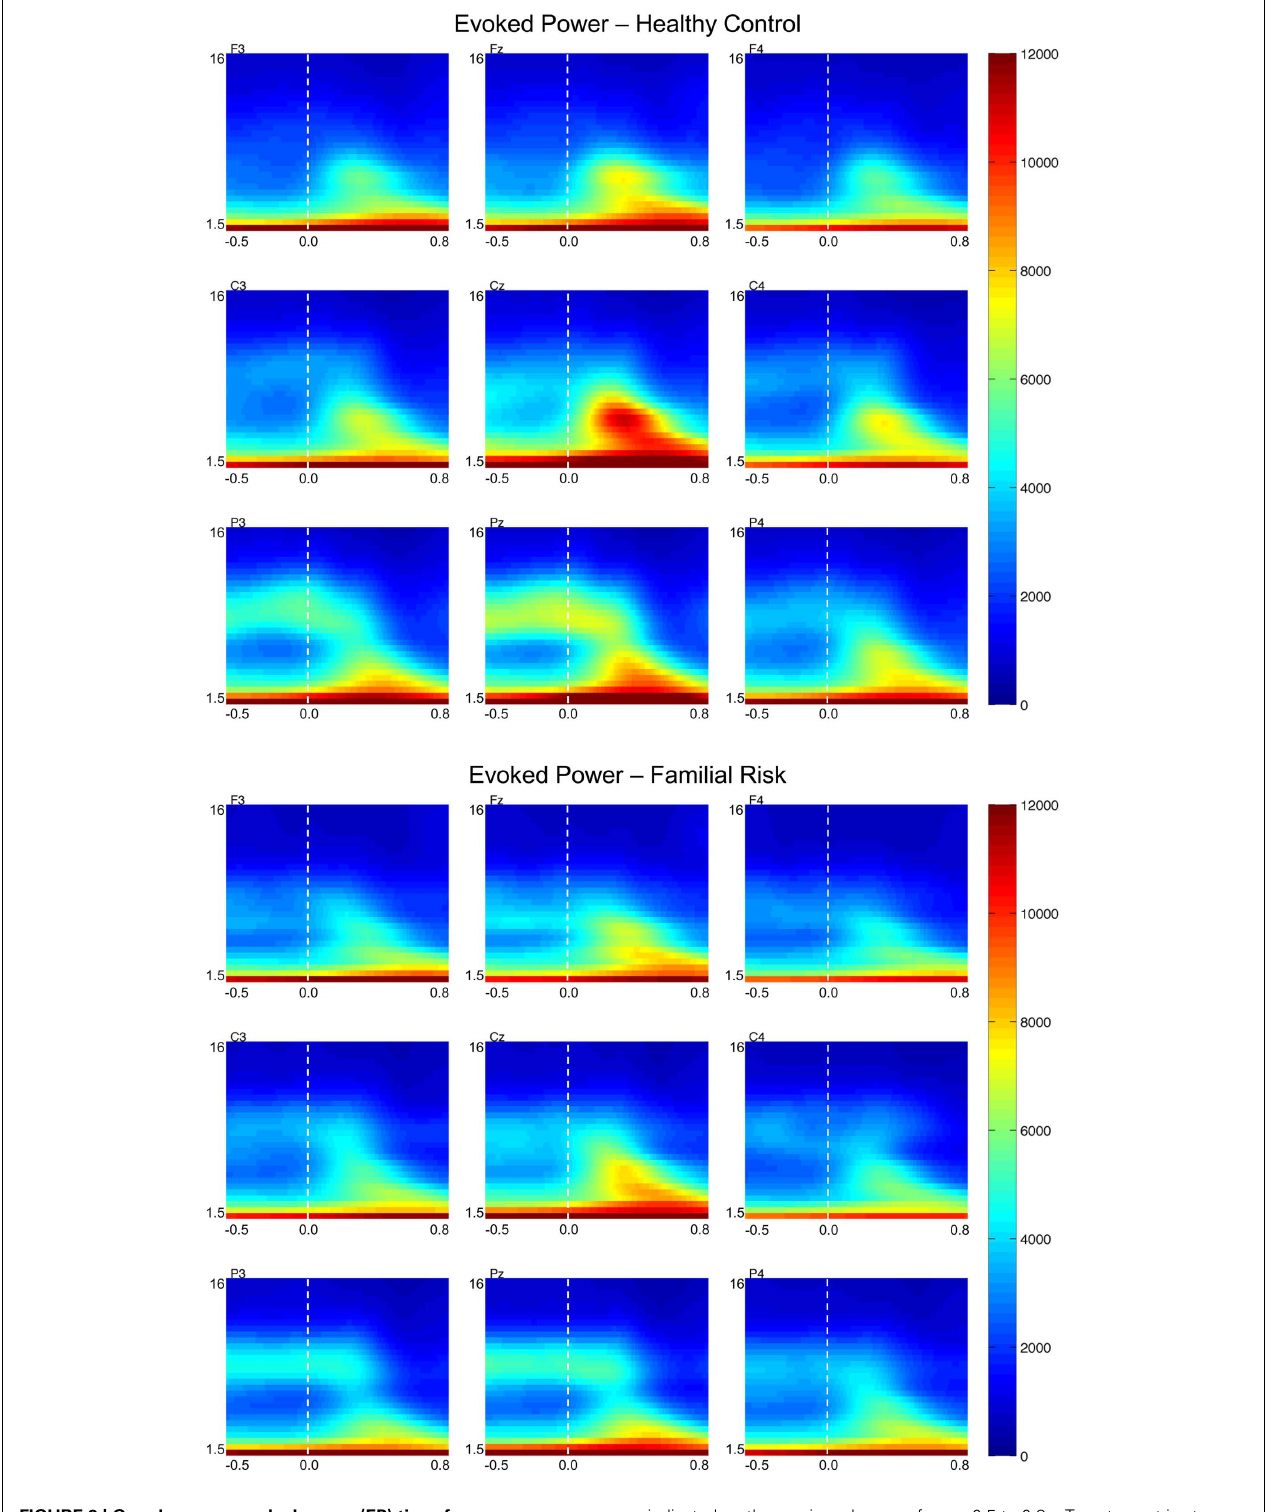
FIGURE 2 | Grand-average evoked power (EP) time–frequency transformations for healthy control (HC) and familial risk (FR) groups at electrodes F3, Fz, F4, C3, Cz, C4, P3, Pz, and P4. EEG frequency is indicated on the y -axis for all panels ranging from 1.5Hz to 16Hz.Time is